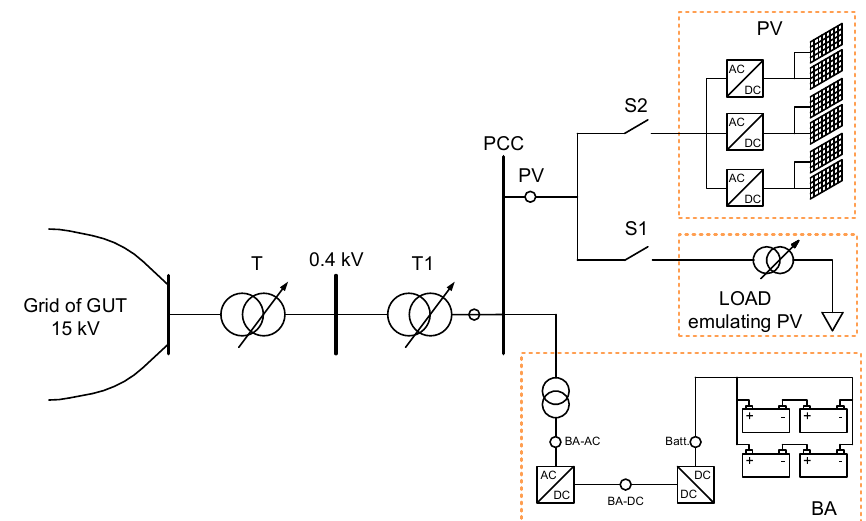
Figure 6. The schematic diagram of a test system with PV emulator by laboratory load model based on power frequency converter or with PV power plant. T: power transformer 15/0.4 kV/kV, T1: transformer of the hybrid PV-BESS system.